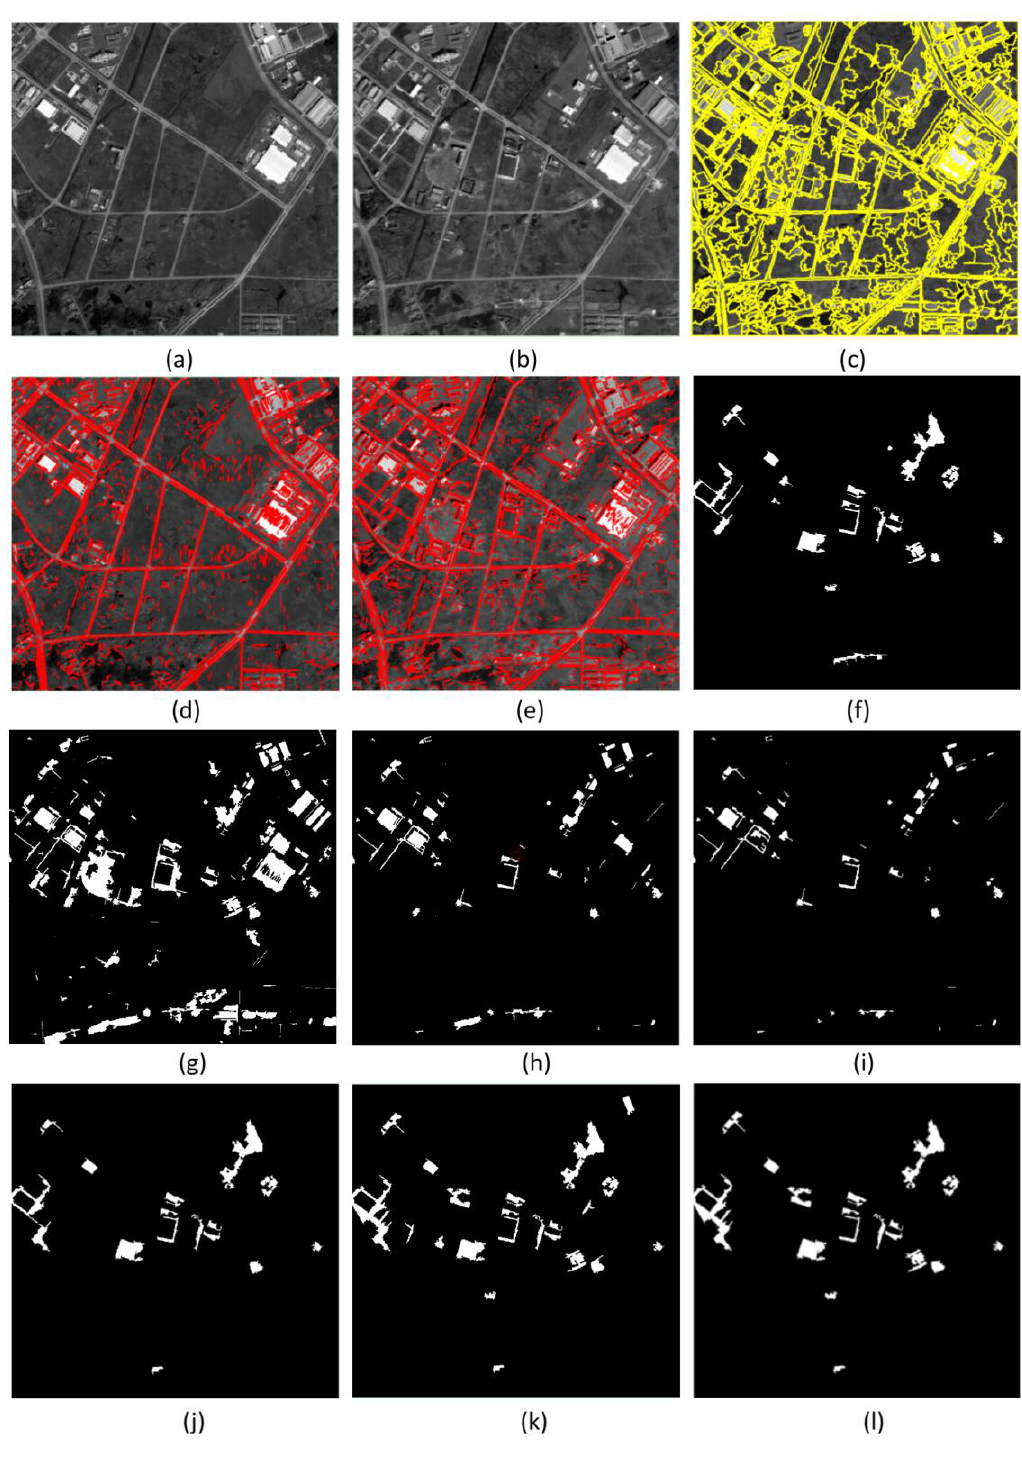
Figure 5. Experimental area 1. ( a , b ) Original bitemporal images. ( c ) Temporal region primitives (TRPs). ( d , e ) Temporal line primitives (TLPs). ( f ) Visual interpretation result. ( g ) Result of change vector analysis (CVA). ( h ) Result of principal component analysis (PCA)-k-means. ( i ) Result of iterative reweighted multivariate alteration detection (IRMAD). ( j ) Result of initial detection. ( k ) Result of direct threshold relaxation. ( l ) Result after refinement. Table 2. Precision in area 1. TP: the number of change image objects correctly detected, FP: the number of unchanged image objects incorrectly detected as changed ones, FN: the number of changed image objects incorrectly detected as unchanged ones, TN: the number of unchanged image objects correctly detected, FA: false alarm, MA: missed alarm, OA: overall accuracy.